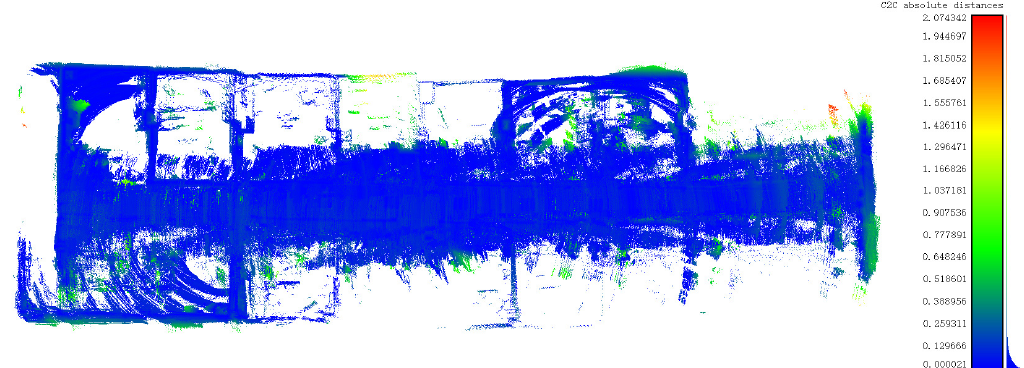
Figure 4. Comparison result of robot &VZ400 point clouds in terms of point-to-plane distance rendered in color. Distance(meter)